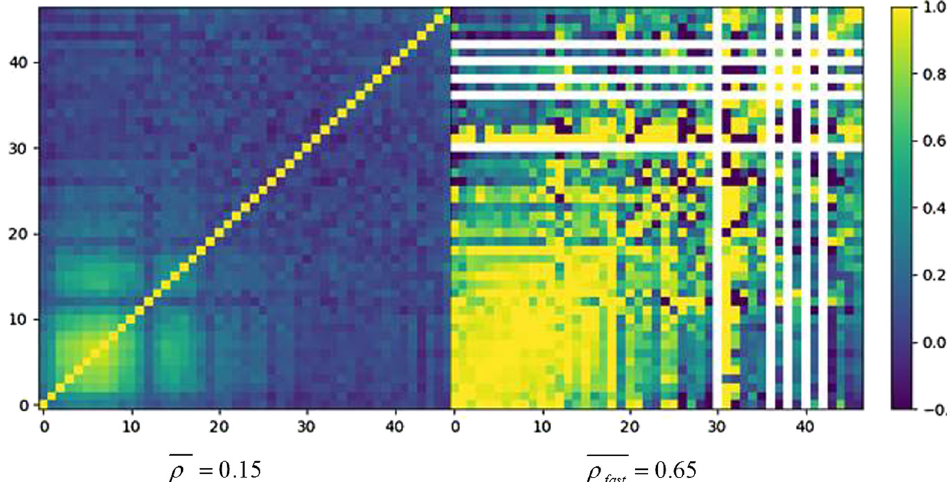
Fig. 2. Results for the NRG high fl ux reactor case. Left: the Pearson correlation coef fi cient obtained using the same data as in reference [12], but on a 47 group energy grid. Right: same as left, but using the fast correlation coef fi cient.